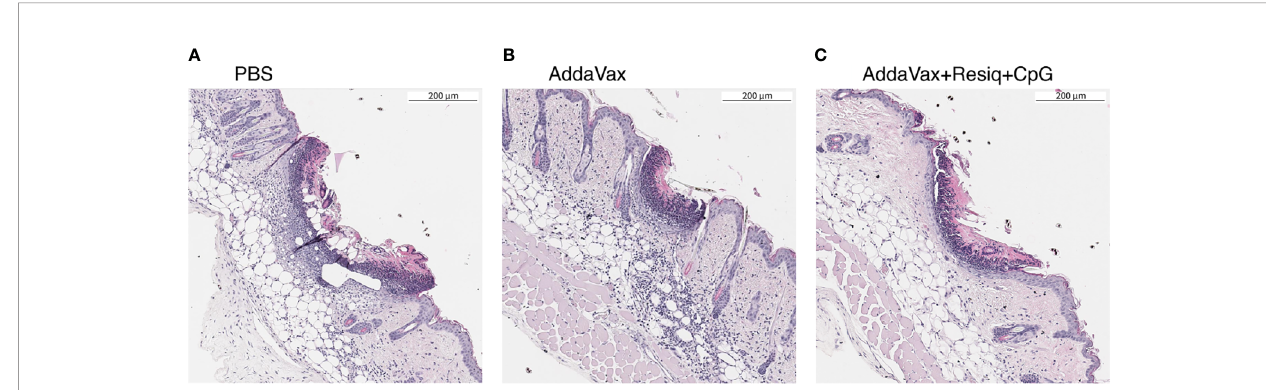
FIGURE 2 | Cellular in fi ltration into dorsal skin 24h post SS prime. Nuclear staining with hematoxylin (H&E) was used as a measure of cellular in fi ltration. Dorsal skin sample were obtained at 24h post SS with CS peptide in (A) PBS, (B) Addavax, or (C) Addavax + Resiquimod + CpG. The pattern of intensity of cell in fi ltration, Addavax > PBS > AddaVax + Resiquimod + CpG was similar in dorsal skin from two independent experiments, with representative results of one experiment